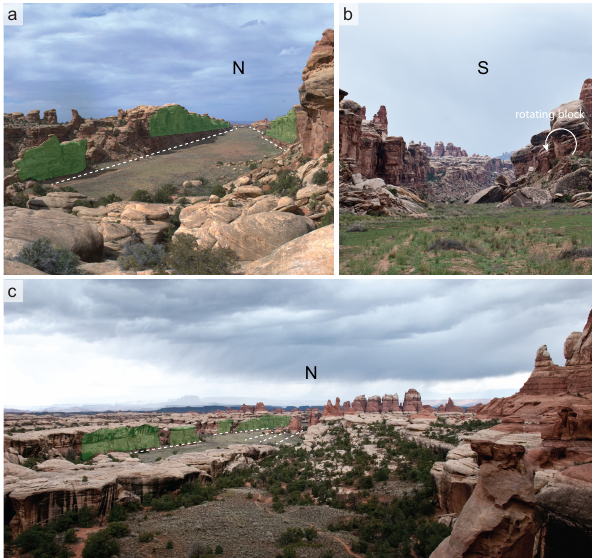
Figure 1. (a) Field photograph from the Devil’s Lane relay fac- ing north. (b) Northern Cyclone Canyon looking south. (c) View over the southern part of Devil’s Pocket looking north. These pho- tographs show the typical caps of the White Cedar Mesa sandstone, inferred faults (dashed lines) along vertical joint surfaces (colored in green) that are typical for this region. A joint set parallel to the faults is clearly visible. In (b) a block rotating into the graben due to reactivation of a joint by underlying faulting is shown in the west.